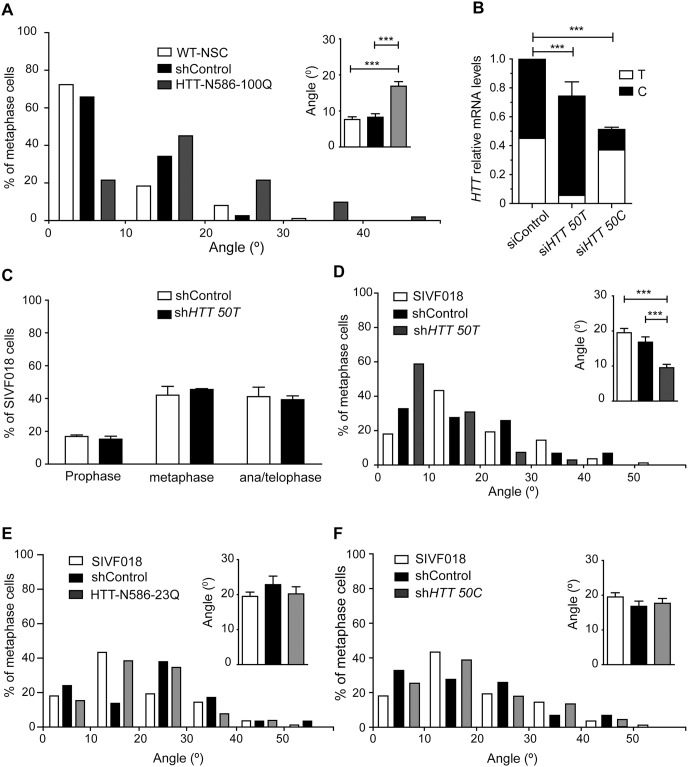
Allele-specific silencing rescues spindle misorientation in NSC derived from HD-hESC.(A) H9-hESC derived neural stem cells were either non-electroporated (WT-NSC) or electroporated as indicated. Distribution and average of spindle angles of metaphase cells are shown. WT-NSC: n = 86, WT-NSC shControl: n = 51, WT-NSC HTT-N586-100Q: n = 38 cells were analysed. (B) HTT allelic ratio measured by RT-qPCR in SIVF018-hESC derived HD-NSCs transfected as indicated every 48 hours; mRNAs were collected at day 7. (C) Distribution of shControl and shHTT50T-treated SIVF018 HD-NSC in prophase, metaphase and ana/telophase. shControl: n = 629, shHTT50T n = 402 cells were analysed. (D, E) SIVF018 HD-NSCs were either non-electroporated or electroporated as indicated. Distribution and average of spindle angles of metaphase cells are shown. (D): SIVF018: n = 83, shControl: n = 61, shHTT50T: n = 68. (E) SIVF018: n = 83, shControl: n = 61, HTT N586-23Q: n = 29 cells were analysed. (F) SIVF018 HD-NSCs were non-electroporated or electroporated as indicated. Distribution and average of spindle angles of metaphase cells are shown. SIVF018: n = 83, shControl: n = 61, shHTT50C: n = 67 cells were analysed. All data are from at least 3 independent experiments. Results are shown as mean values ± SEM. ***p<0.001; Student’s t-test.